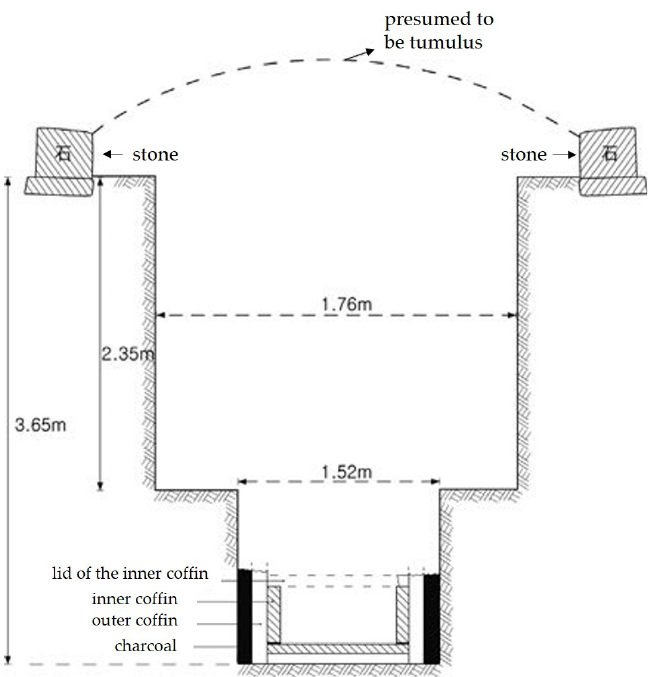
Figure 11. Diagram of the burial facilities of the Nongso Tomb. After (Kungnip Naju munhwajae yŏn’guso 2016, p. 130, Diagram 35) with modifications.